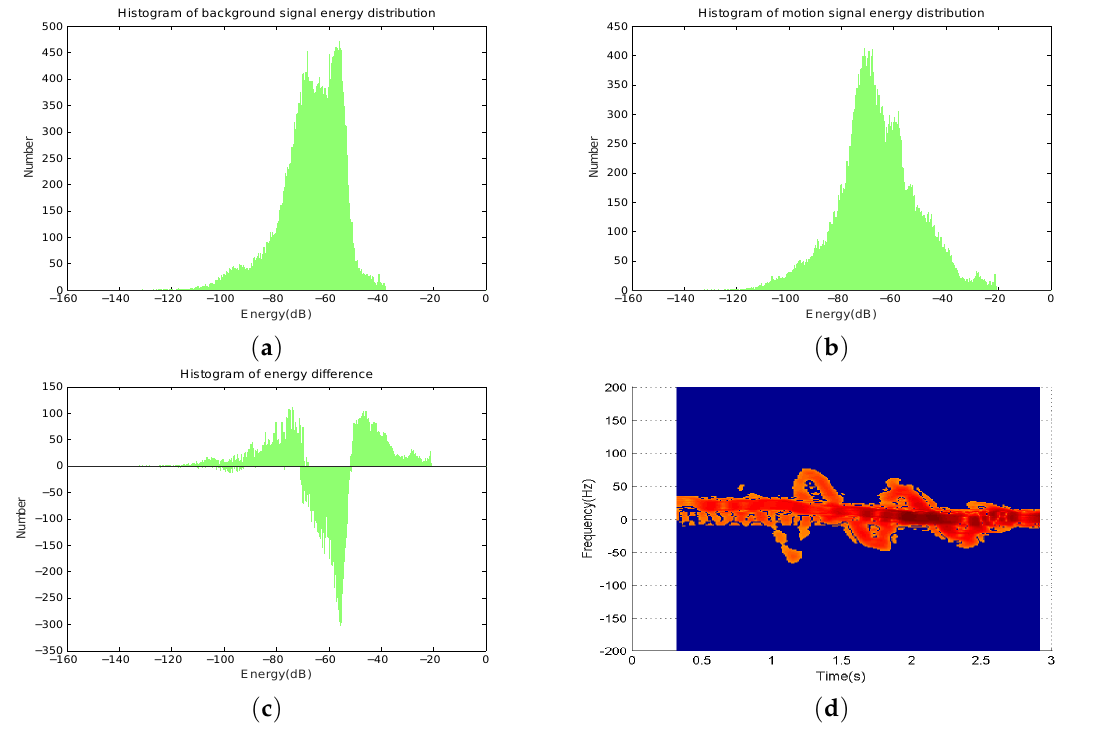
Figure 6. ( a ) is a histogram of background signal energy distribution; ( b ) is a histogram of motion signal energy distribution; ( c ) is a histogram of difference; ( d ) is the result of threshold